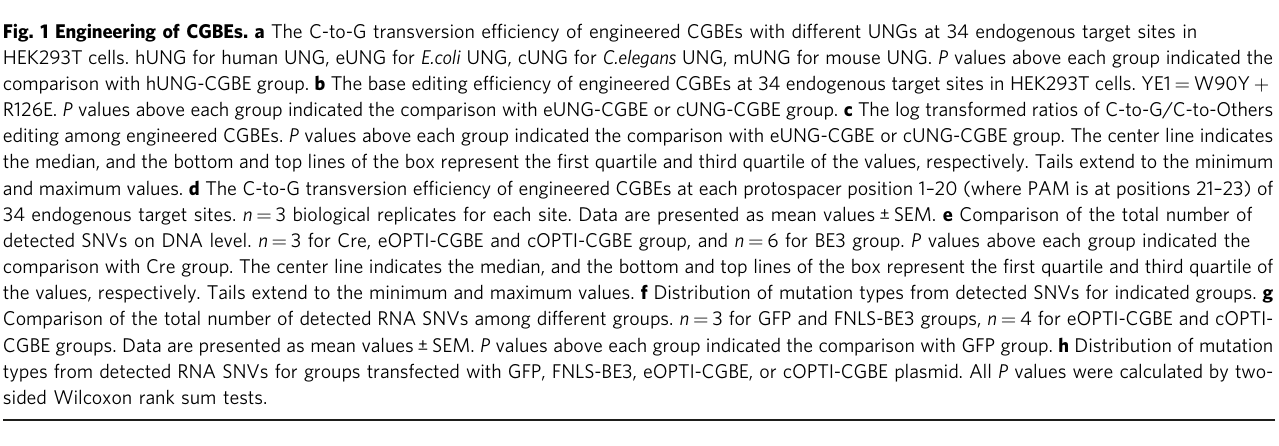
Fig. 1 Engineering of CGBEs. a The C-to-G transversion ef fi ciency of engineered CGBEs with different UNGs at 34 endogenous target sites in HEK293T cells. hUNG for human UNG, eUNG for E.coli UNG, cUNG for C.elegans UNG, mUNG for mouse UNG. P values above each group indicated the comparison with hUNG-CGBE group. b The base editing ef fi ciency of engineered CGBEs at 34 endogenous target sites in HEK293T cells. YE1 = W90Y + R126E. P values above each group indicated the comparison with eUNG-CGBE or cUNG-CGBE group. c The log transformed ratios of C-to-G/C-to-Others editing among engineered CGBEs. P values above each group indicated the comparison with eUNG-CGBE or cUNG-CGBE group. The center line indicates the median, and the bottom and top lines of the box represent the fi rst quartile and third quartile of the values, respectively. Tails extend to the minimum and maximum values. d The C-to-G transversion ef fi ciency of engineered CGBEs at each protospacer position 1 – 20 (where PAM is at positions 21 – 23) of 34 endogenous target sites. n = 3 biological replicates for each site. Data are presented as mean values ± SEM. e Comparison of the total number of detected SNVs on DNA level. n = 3 for Cre, eOPTI-CGBE and cOPTI-CGBE group, and n = 6 for BE3 group. P values above each group indicated the comparison with Cre group. The center line indicates the median, and the bottom and top lines of the box represent the fi rst quartile and third quartile of the values, respectively. Tails extend to the minimum and maximum values. f Distribution of mutation types from detected SNVs for indicated groups. g Comparison of the total number of detected RNA SNVs among different groups. n = 3 for GFP and FNLS-BE3 groups, n = 4 for eOPTI-CGBE and cOPTI- CGBE groups. Data are presented as mean values ± SEM. P values above each group indicated the comparison with GFP group. h Distribution of mutation types from detected RNA SNVs for groups transfected with GFP, FNLS-BE3, eOPTI-CGBE, or cOPTI-CGBE plasmid. All P values were calculated by two- sided Wilcoxon rank sum